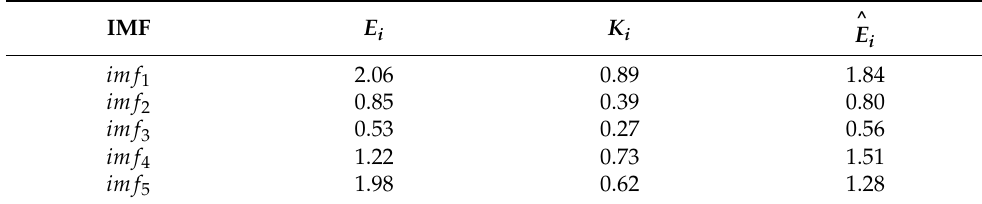
Table 2. The E , K , and ˆ E of each Table 2. The  ,  , and  of each IMF.